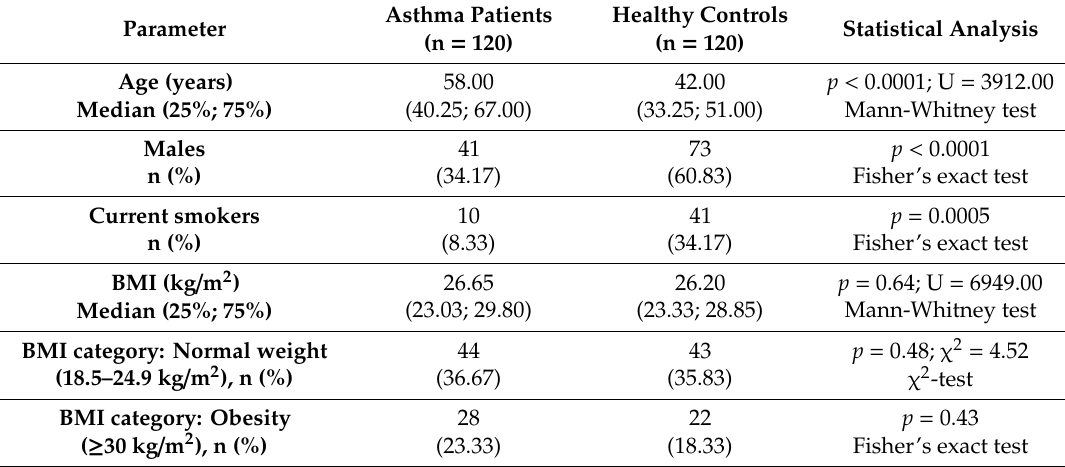
Table 1. Characteristics of asthma patients and healthy